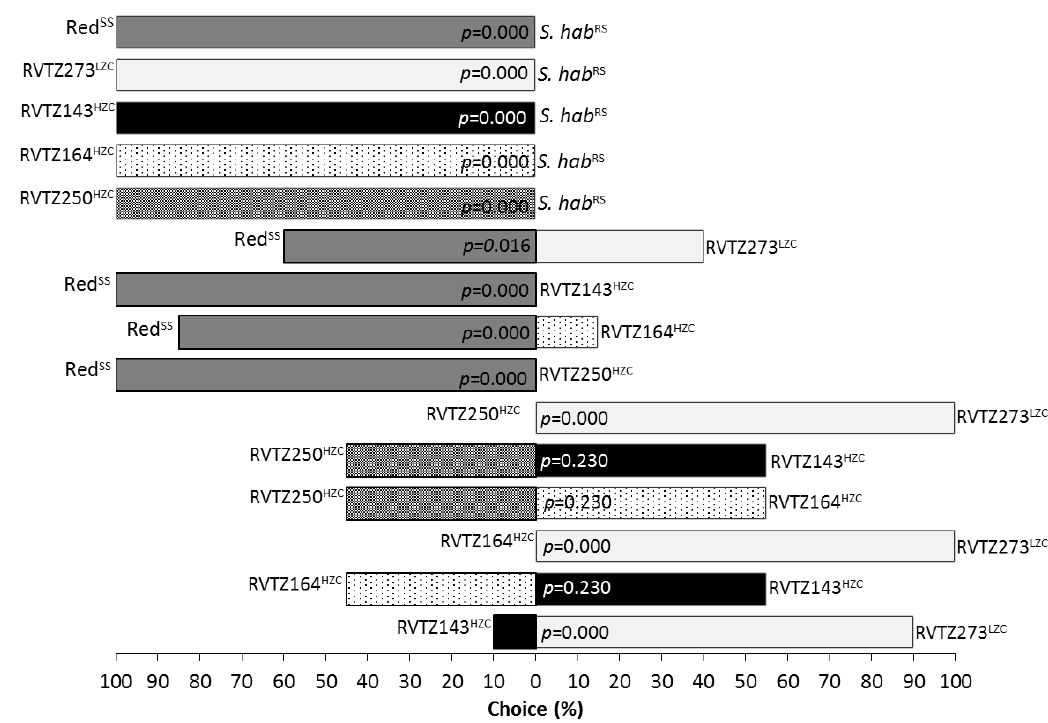
Figure 2. Frequency of choice of Tetranychus urticae in relation to tomato F 2 BC 2 genotypes ( n = 10). Red = Solanum lycopersicum cv. Redenção; PI-127826 = Solanum habrochaites var. hirsutum PI-127826; 273 = RVTZ 2011-79-117-273 (with low zingiberene content); 143 = RVTZ 2011-79-503-143; 164 = RVTZ 2011-79-503-164; and 250 = RVTZ 2011-79-503-250 (with high zingiberene content). p -value indicates the statistical significance according to the Chi-square test. SS = Susceptible Standard genotype; RS = Resistant standard genotype; HZC = high zingiberene content; LZC = low zingiberene content.